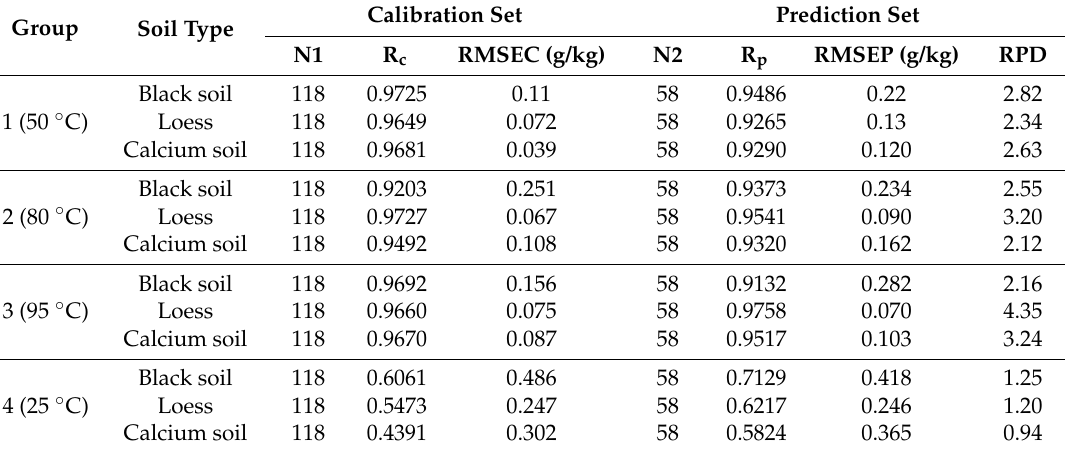
Table 2. The modeling results of different soils and temperatures by SPA-MLR. RMSEC: root mean square error (RMSE) of the calibration set; RMSEP: RMSE of the prediction set; RPD: residual predictive